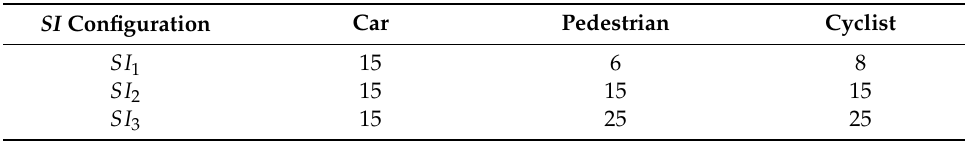
Table 2. Number of sampling instances ( SI ) per class.